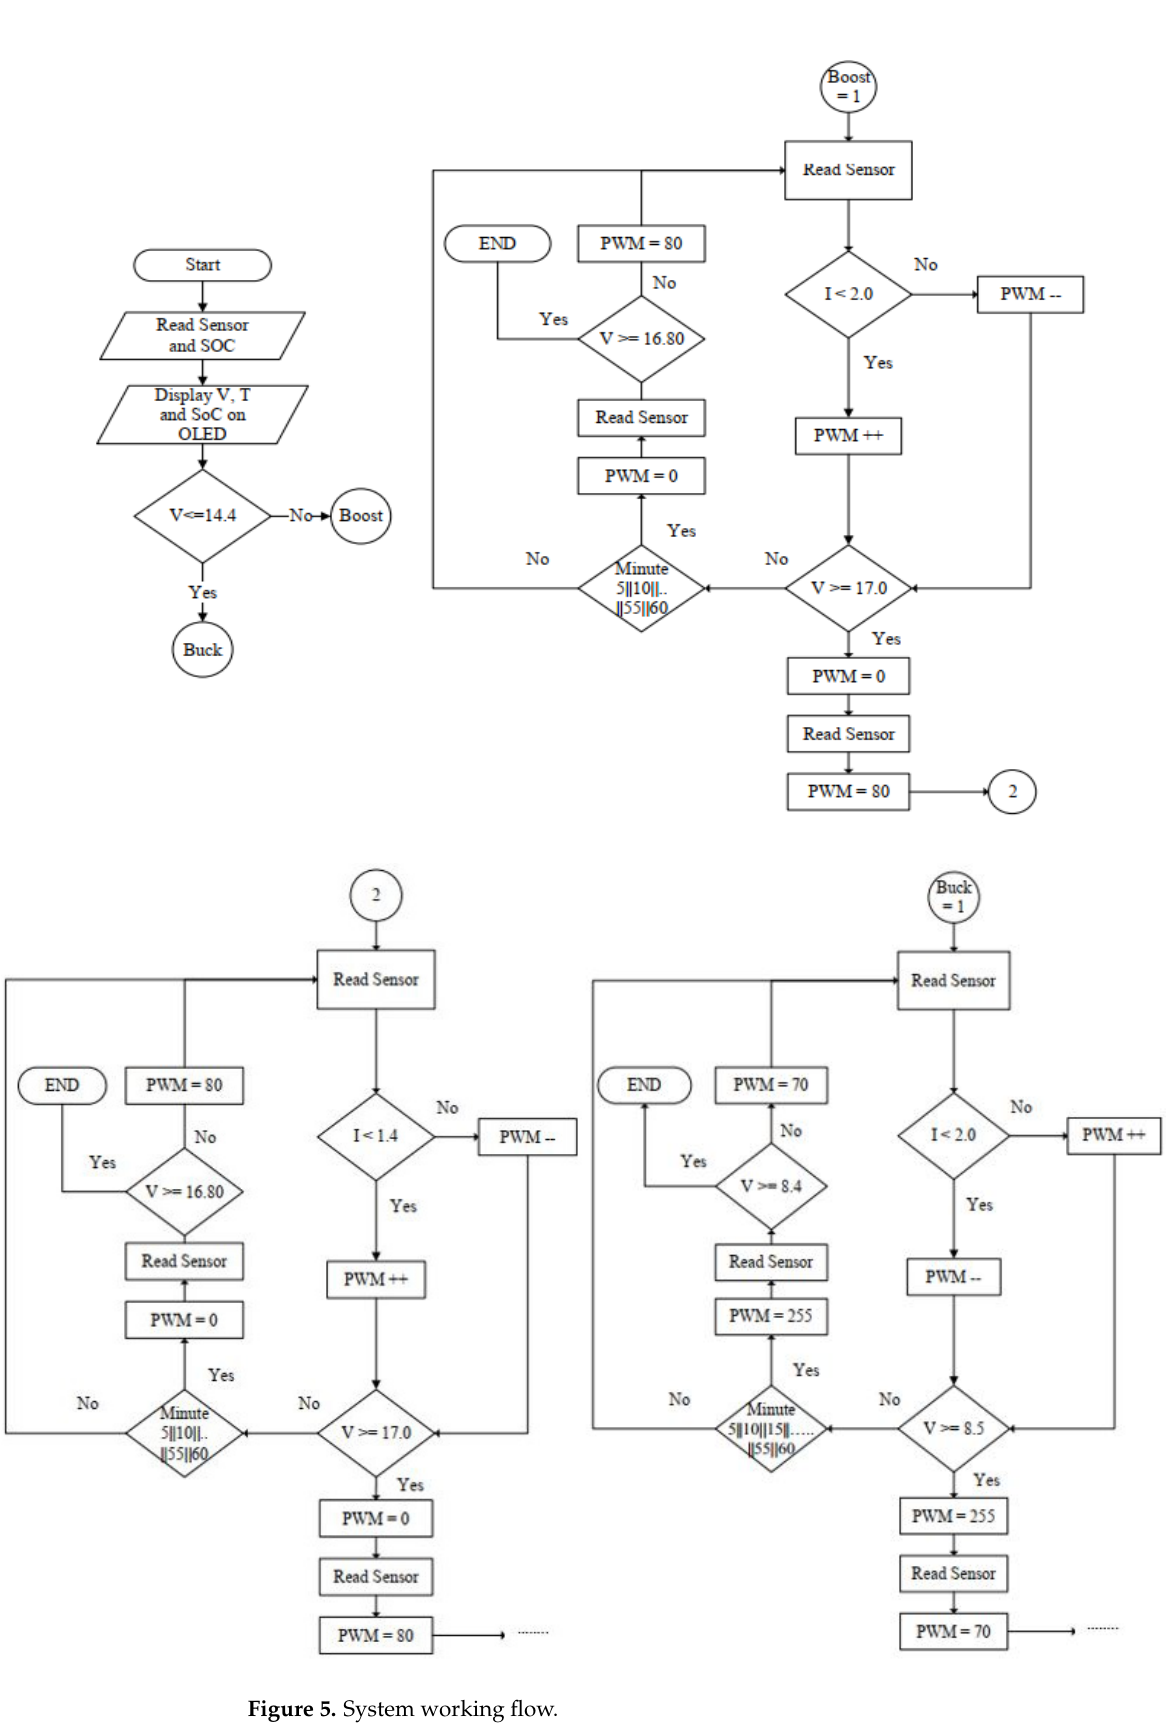
Figure 5. System working flow.